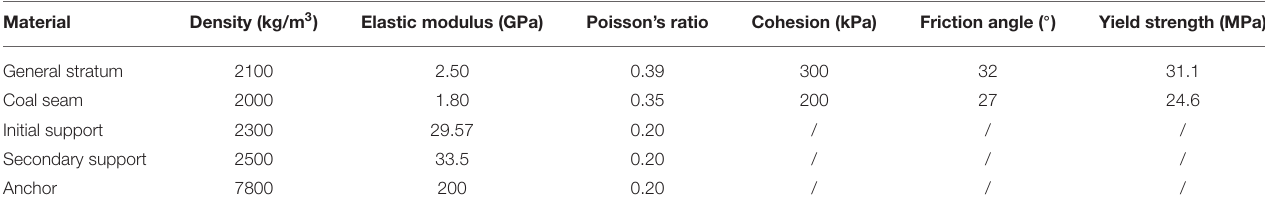
TABLE 5 | Physical-mechanical properties of the material at